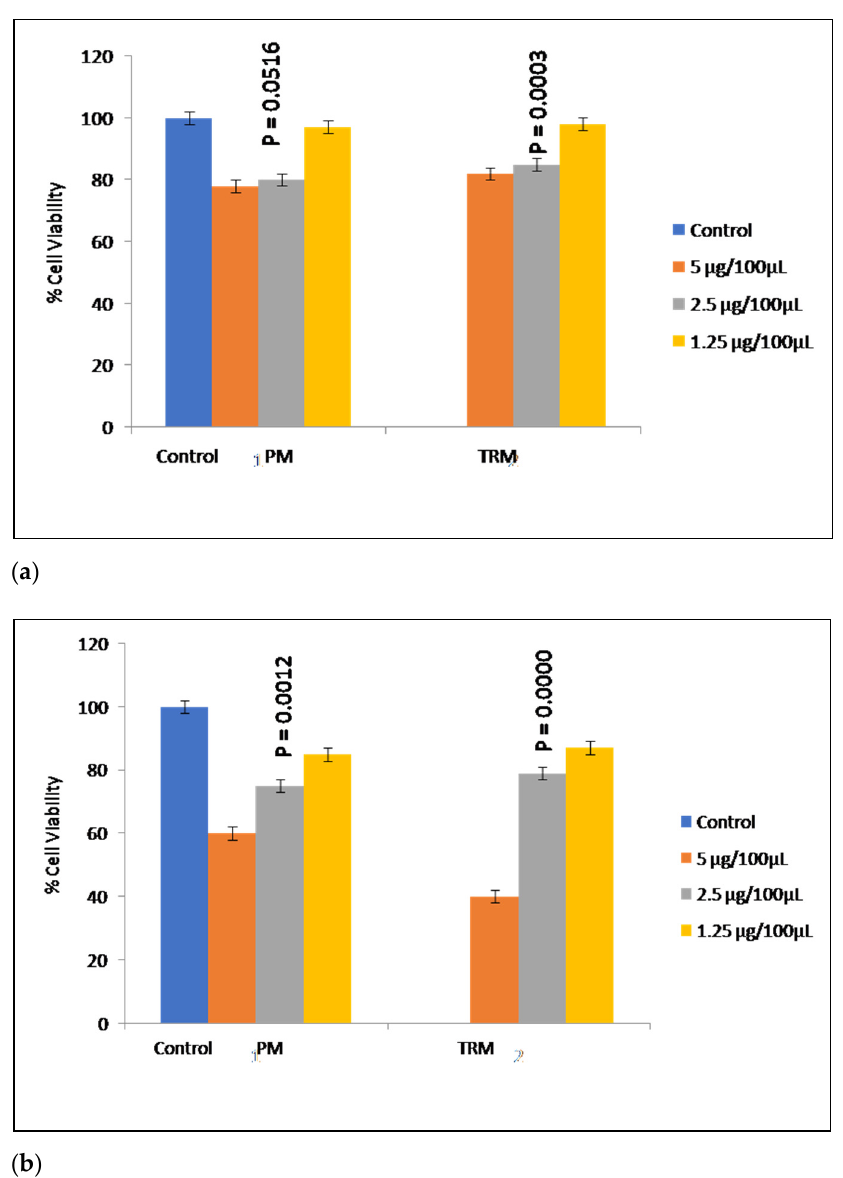
Figure 5. ( a ) A ctotoxicity study of PM and synthesized TRM on L929 fibroblast cell lines; ( b ) in vitro anticancer studies of PM and synthesized TRM on human cervical cancer HeLa cell lines.